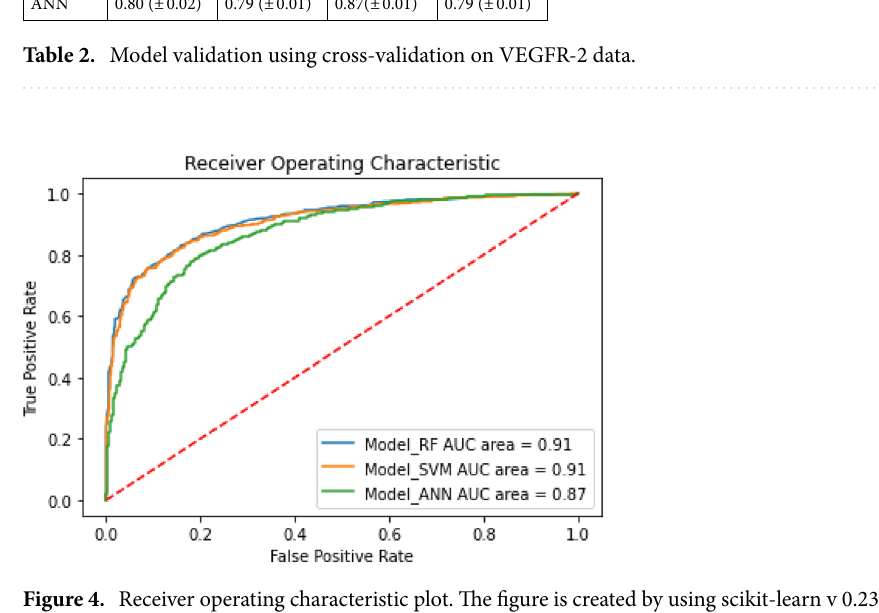
Figure 4. Receiver operating characteristic plot. The figure is created by using scikit-learn v 0.23.1, https:// scikit- learn.